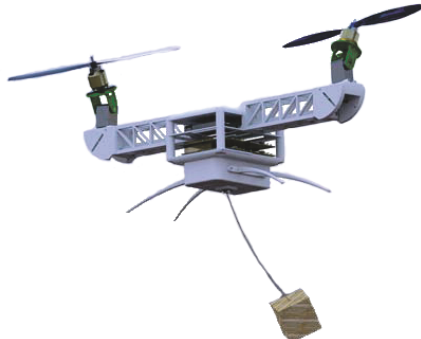
Figure 1: The tilt-rotor UAV with suspended load (CAD